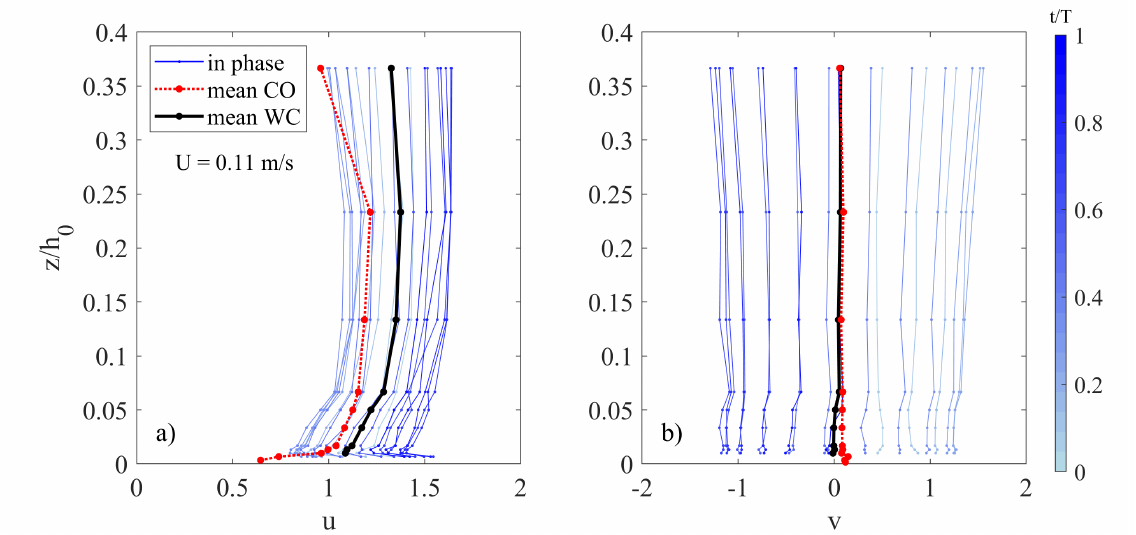
Figure 12. Phase-averaged velocities for tests 6 and 12 (CO and WC respectively) in the streamwise ( a ) and crosswise ( b ) directions. Time-averaged CO profile (red dashed line, red dot marker), time-averaged WC profile (black thick continuous line, black dot marker) and phase-averaged WC profile (see color bar). Mean velocity U = 0.11 m/s, local water depth h = 0.24